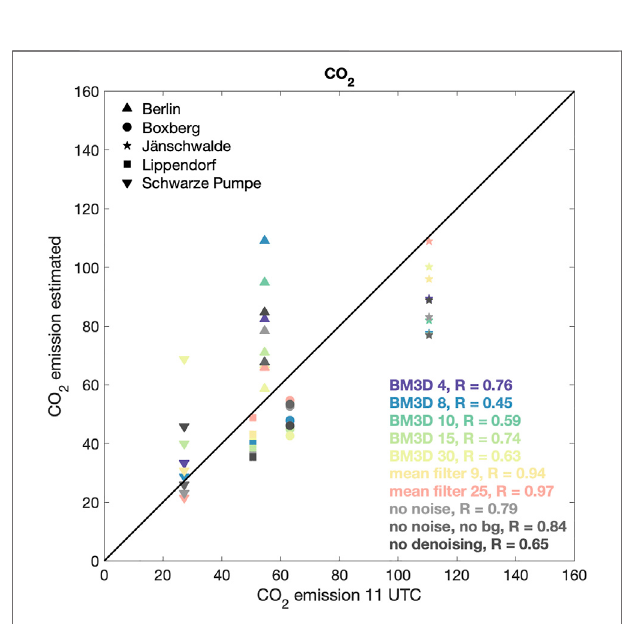
FIGURE 6 | Source-speci fi c CO 2 emissions calculated with different denoising methods (shown as different colors). See Figures 3 , 5 for the corresponding divergence